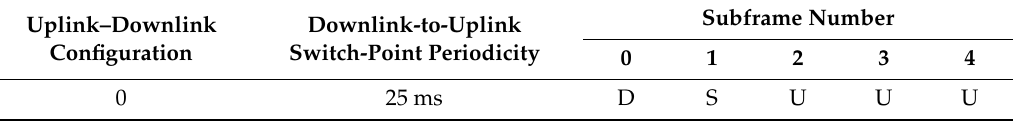
Table 3. Uplink–downlink configurations of LTE 230.